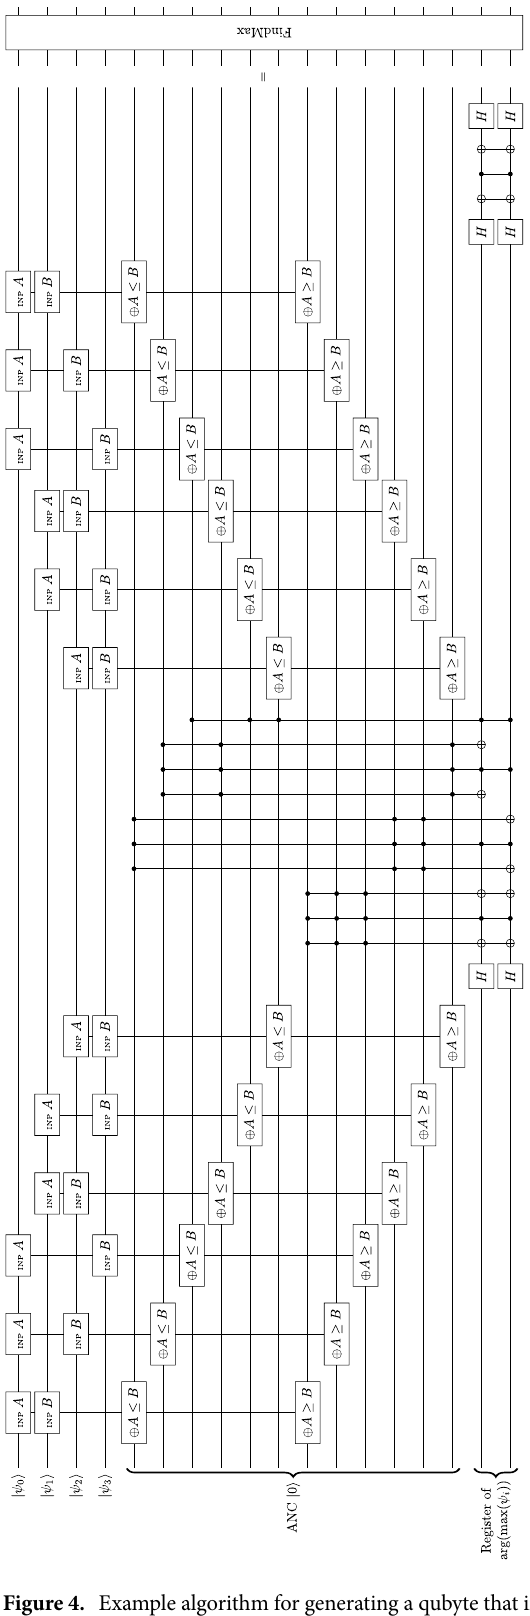
Figure 4. Example algorithm for generating a qubyte that indexes the maximum of 4 qubits